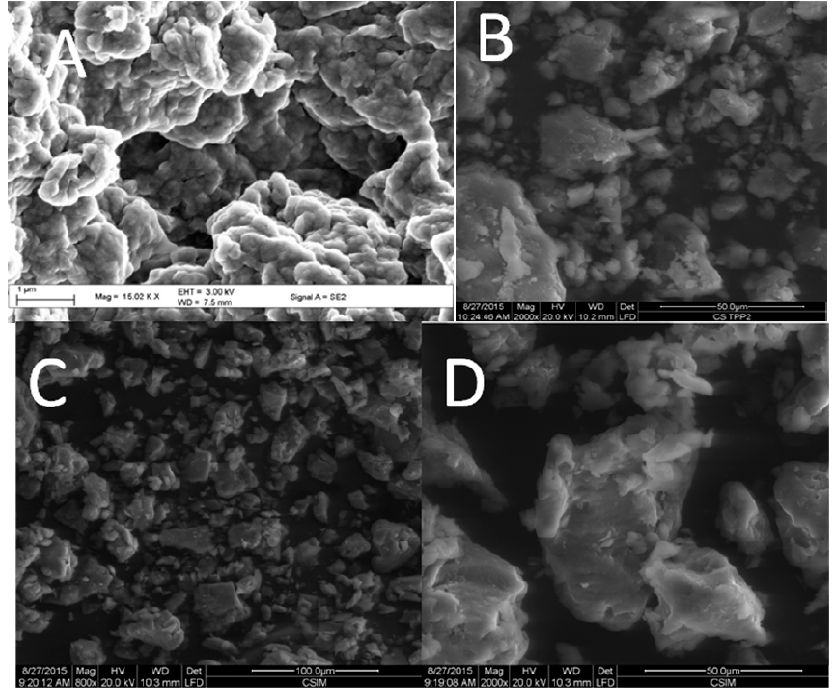
Figure 7. SEM images of ( A ) chitosan (scale bar = 1 μ m); ( B ) CS/TPP (scale bar = 50 μ m); ( C ) PANV-CS/TPP (scale bar = 100 μ m); and ( D ) PANV-CS/TPP (scale bar = 50 μ m).